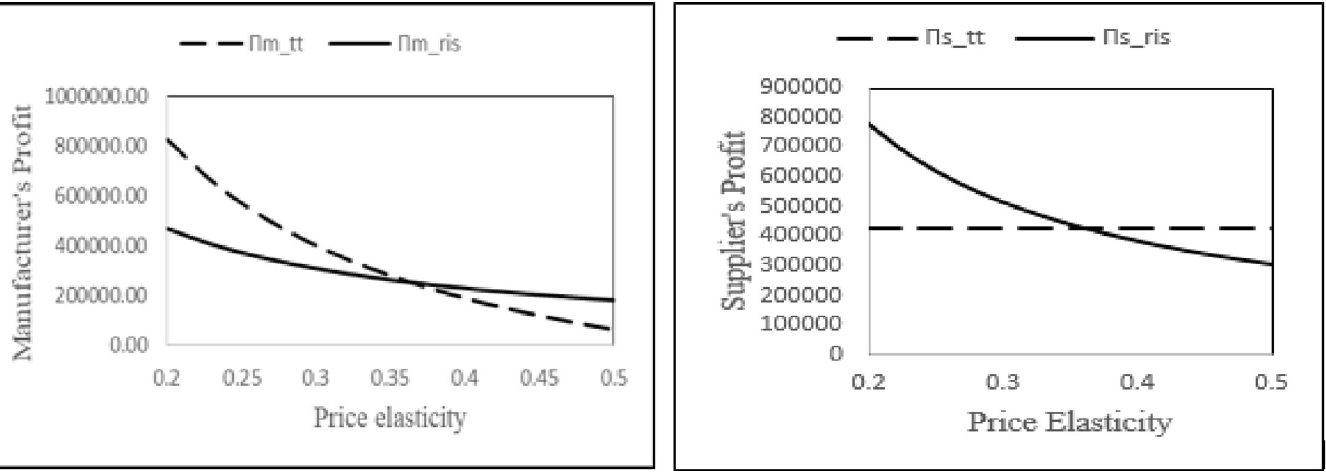
PLOS ONE | https://doi.org/10.1371/journal.pone.0277777 November17,